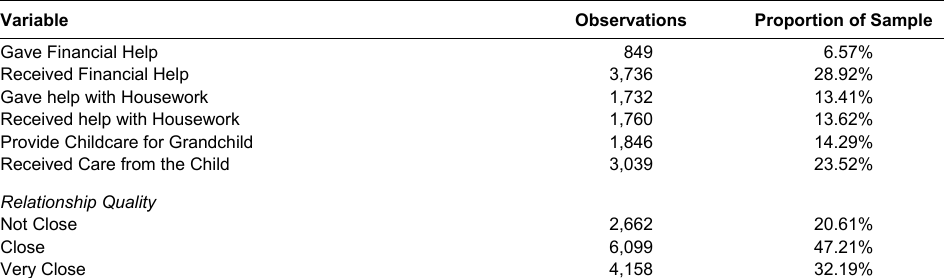
Table 1 : Parent-Child Relationship